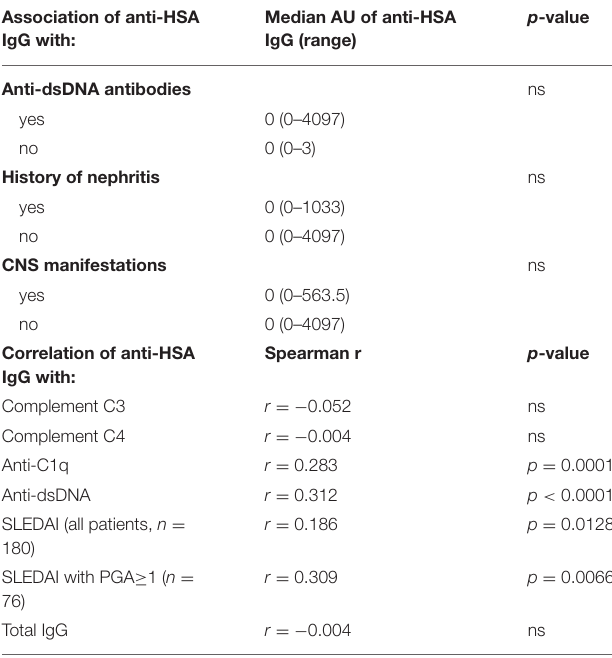
TABLE 2 | Association and correlation of anti-HSA